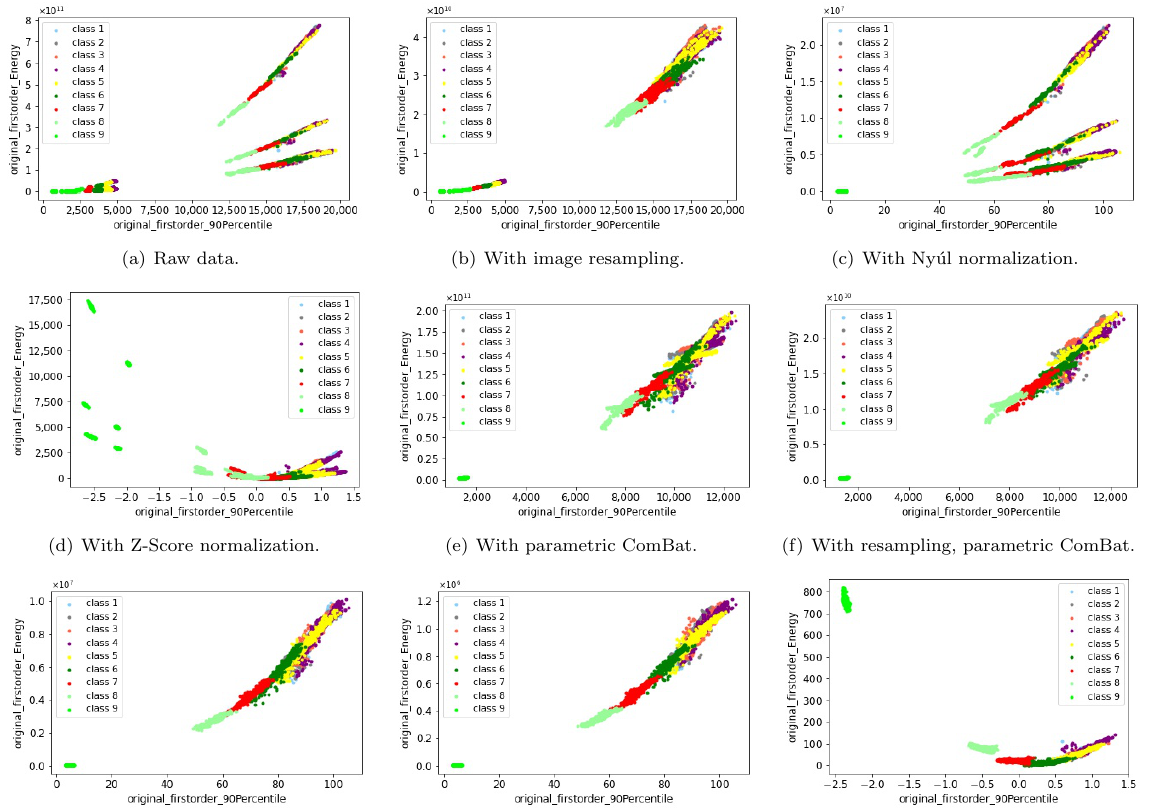
Figure 9. Visualize two features (“90th percentile” and “energy”) of the homogeneous phantom in a 2D plane, with different preprocessing and harmonization methods. Here “class 1” to “class 9” correspond to the nine homogeneous phantom tubes. The subfigures show the two example features acquired from MRI images ( a ) without applying any preprocessing and harmonization methods (raw data), ( b ) with only applying the image resampling, ( c ) with only applying the Nyúl normalization, ( d ) with only applying the Z-Score normalization, ( e ) with only applying the parametric ComBat, ( f ) with applying the resampling and parametric ComBat, ( g ) with applying the Nyúl normalization and parametric ComBat, ( h ) with applying the resampling, Nyúl normalization and parametric ComBat, and ( i ) with applying the resampling, Z-Score and parametric